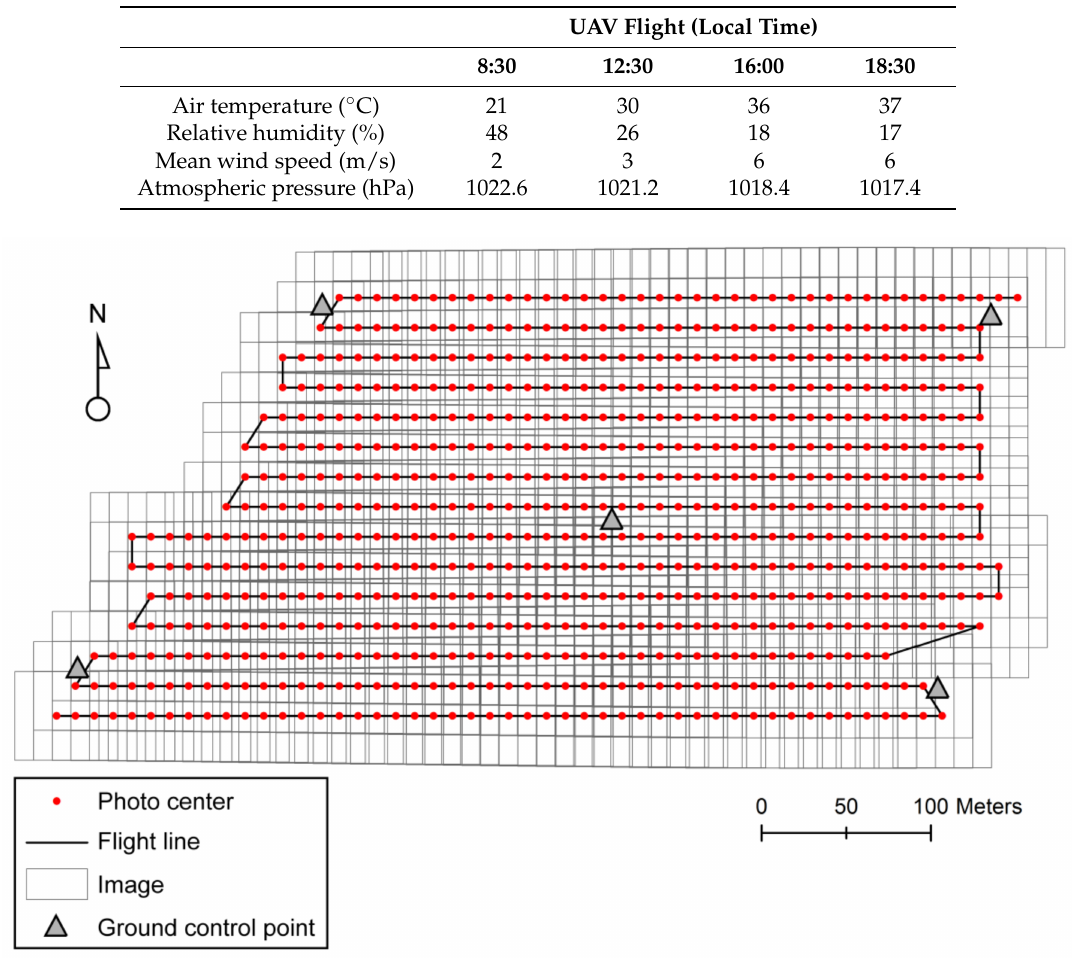
Figure 2. Flight planning and distribution of ground control